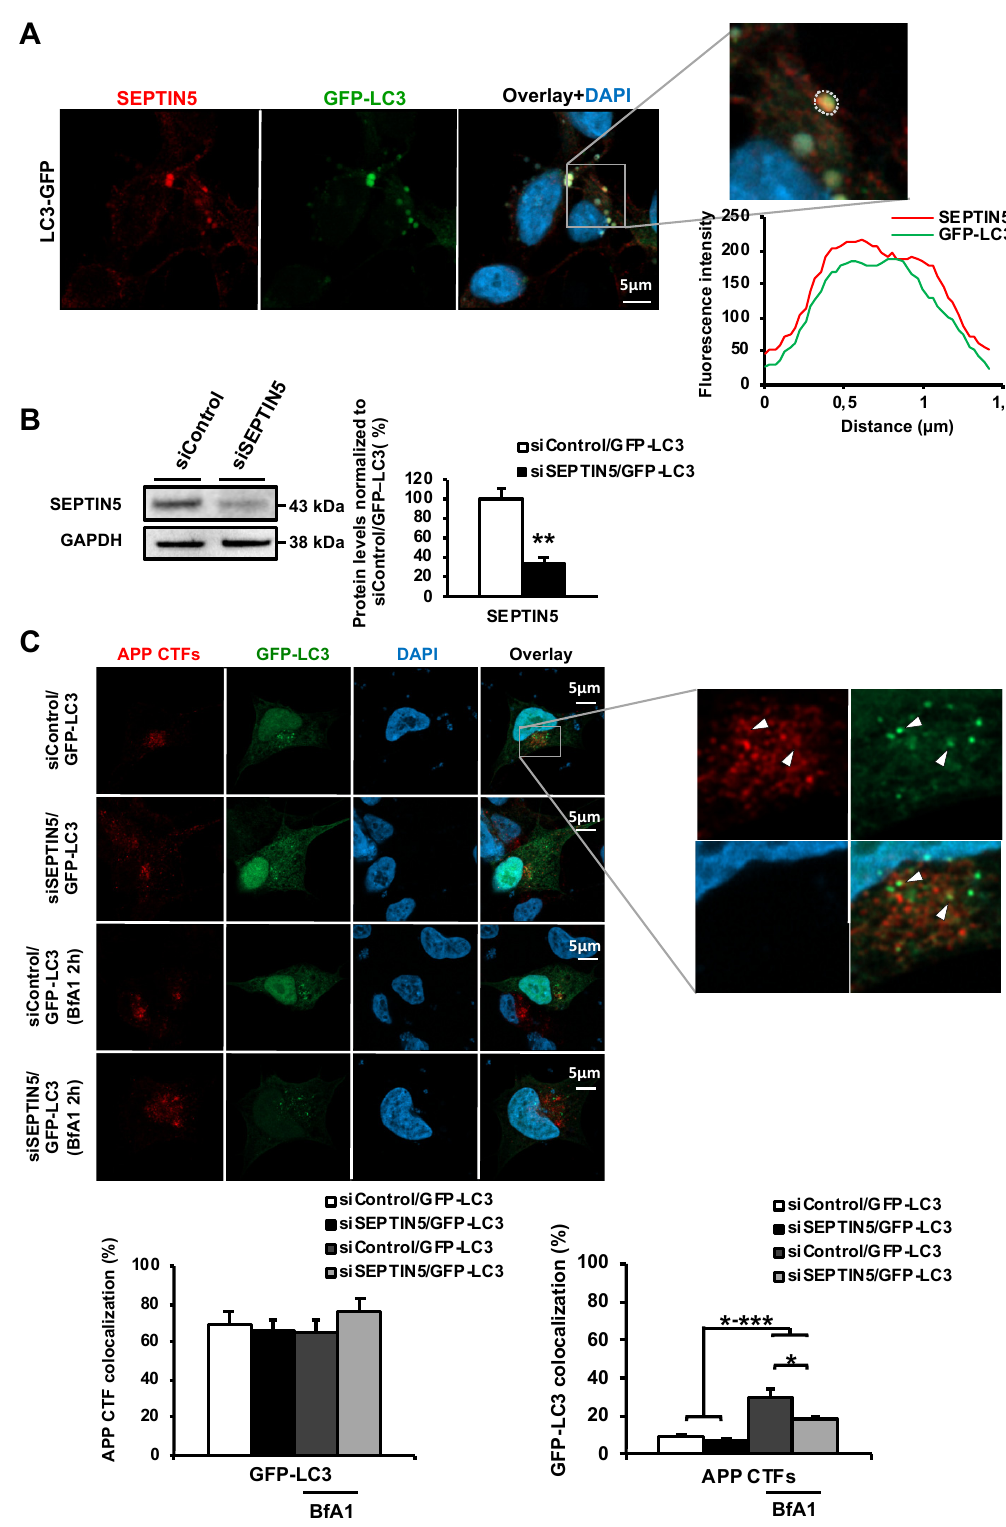
Figure 5. SEPTIN5 colocalizes with GFP-LC3-positive autophagosomal vesicles and the downregulation of SEPTIN5 does not alter the colocalization of APP CTFs with GFP-LC3 in SH-SY5Y-APP751 cells. ( A ) Superresolution confocal images of endogenous SEPTIN5 (red) in immunostained GFP-LC3-transfected SH-SY5Y-APP751 cells. Quantification of the overlapping fluorescence intensity of a GFP-LC3 positive vesicle shows a marked colocalization for SEPTIN5 and GFP-LC3 (region of interest is indicated with white dotted line); ( B ) Western blot analysis showing SEPTIN5 downregulation in SEPTIN5 siRNA-transfected SH-SY5Y-APP751 cells, n = 4, mean ± SEM,